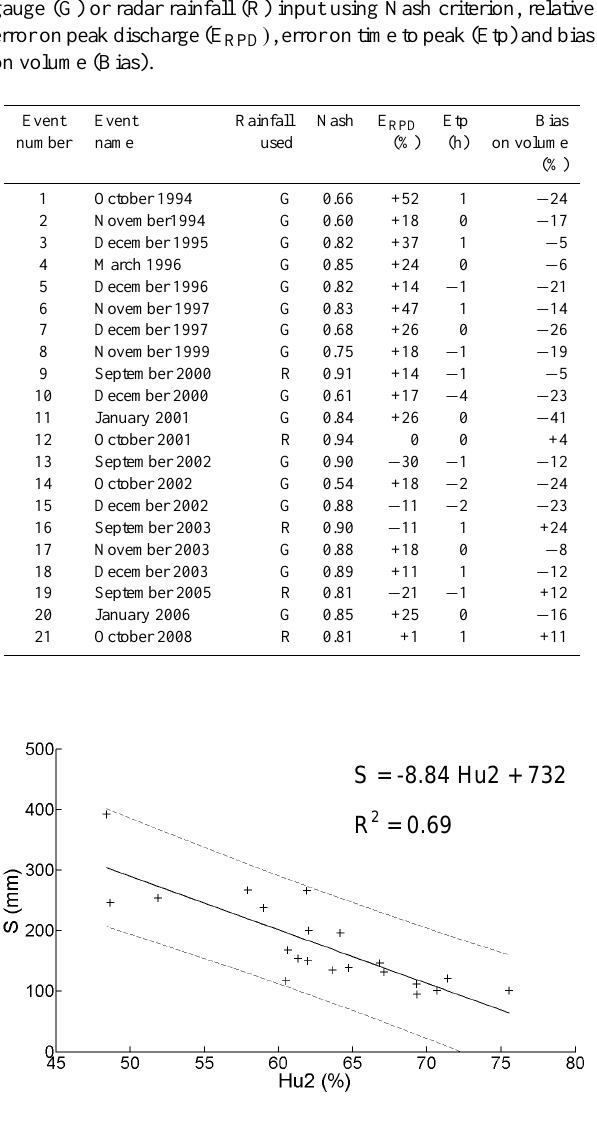
Fig. 6. Linear regression between model initial condition S and Hu2 index of SIM model. The dashed lines represent the 95% con- Figure 6: linear regression between the model initial condition S and the Hu2 index from the 2 fidence limits. SIM model. The dashed lines represent the 95% confidence limits. 3